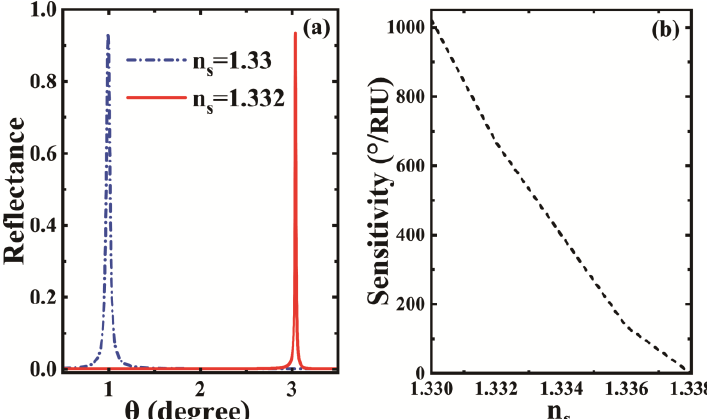
Figure 3. ( a ) Reflectance of the liquid biosensor structure relative to the refractive index of the sensing layer for different sensing layers; ( b ) variation curve of the sensitivity of the biosensor structure relative to the refractive index of the sensing layer. The initial parameters are E F = 0.75 eV, d =152 μ m .